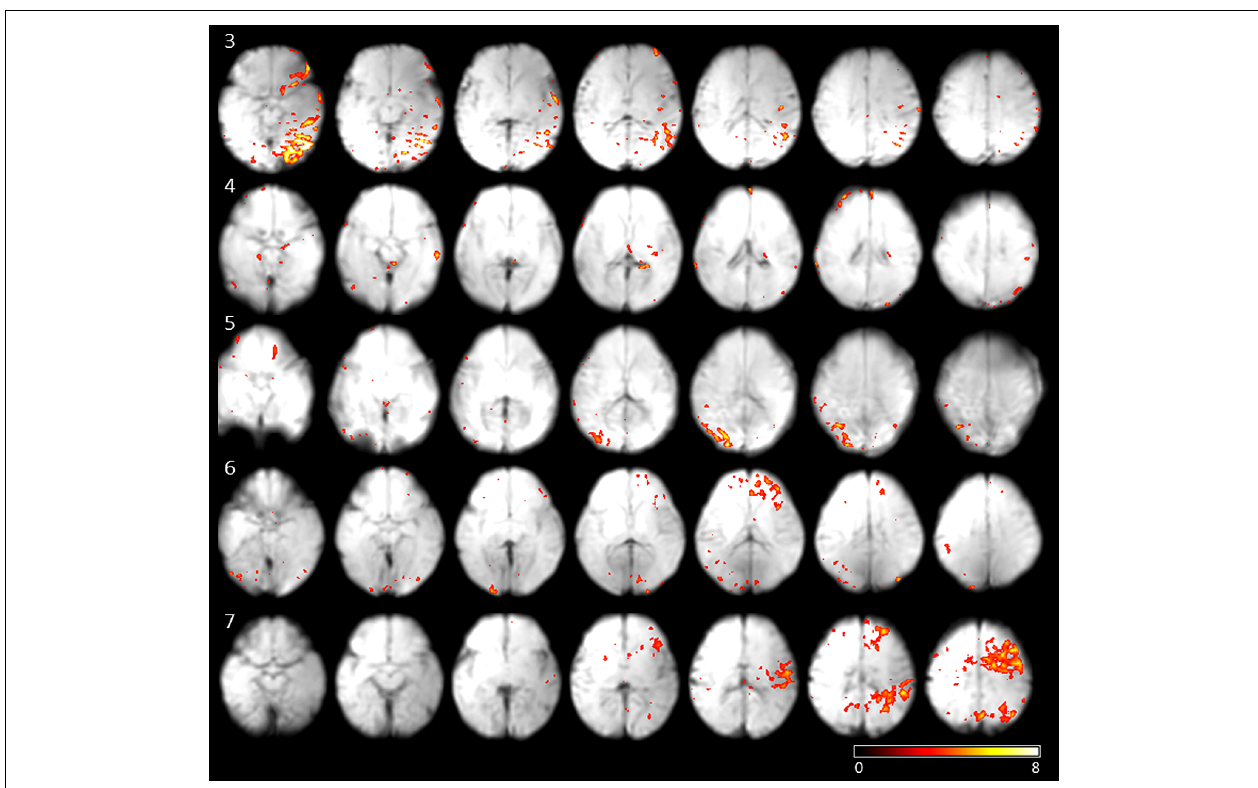
FIGURE 3 | Results of subjects 3–7 of the independent components with the maximum correlation coefficients with the eye movement on-set regressor derived from eye tracking. Maps are overlaid on individual mean EPIs.